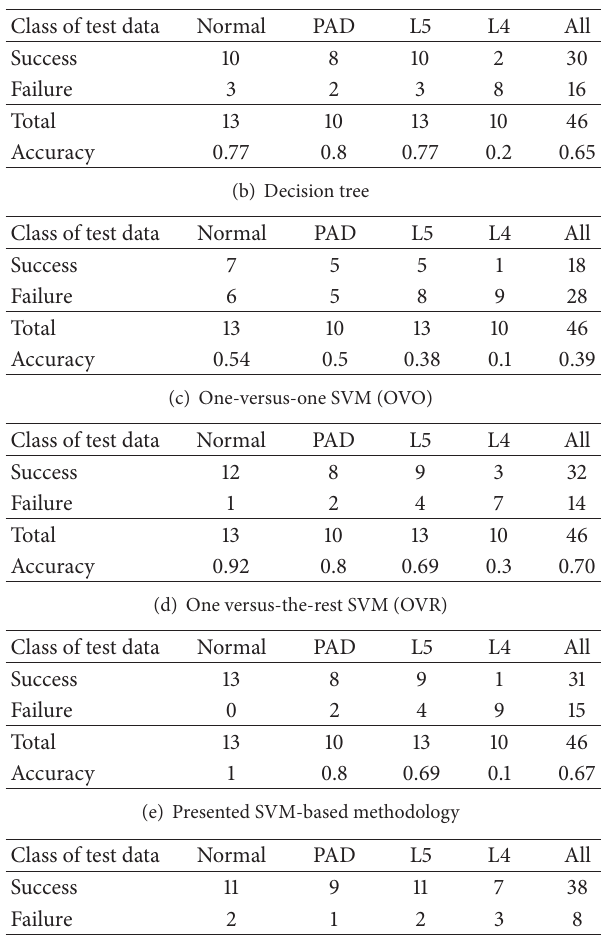
Table 3: Classification results at every classifier. (a) LDA (linear discriminant